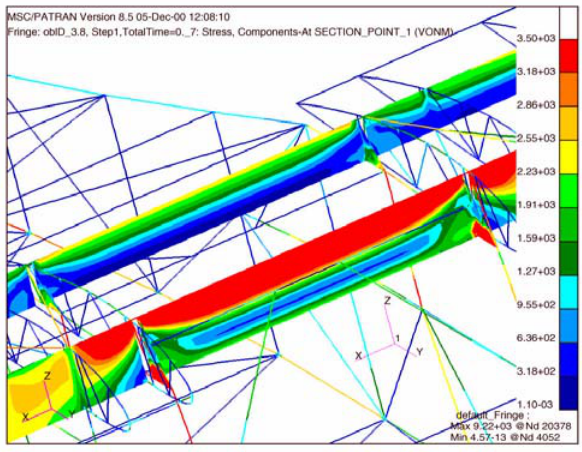
Fig 5. Effective stress in carrying beam of the fuselage (von Misses). Notice compression of upper strips with 350[MPa]